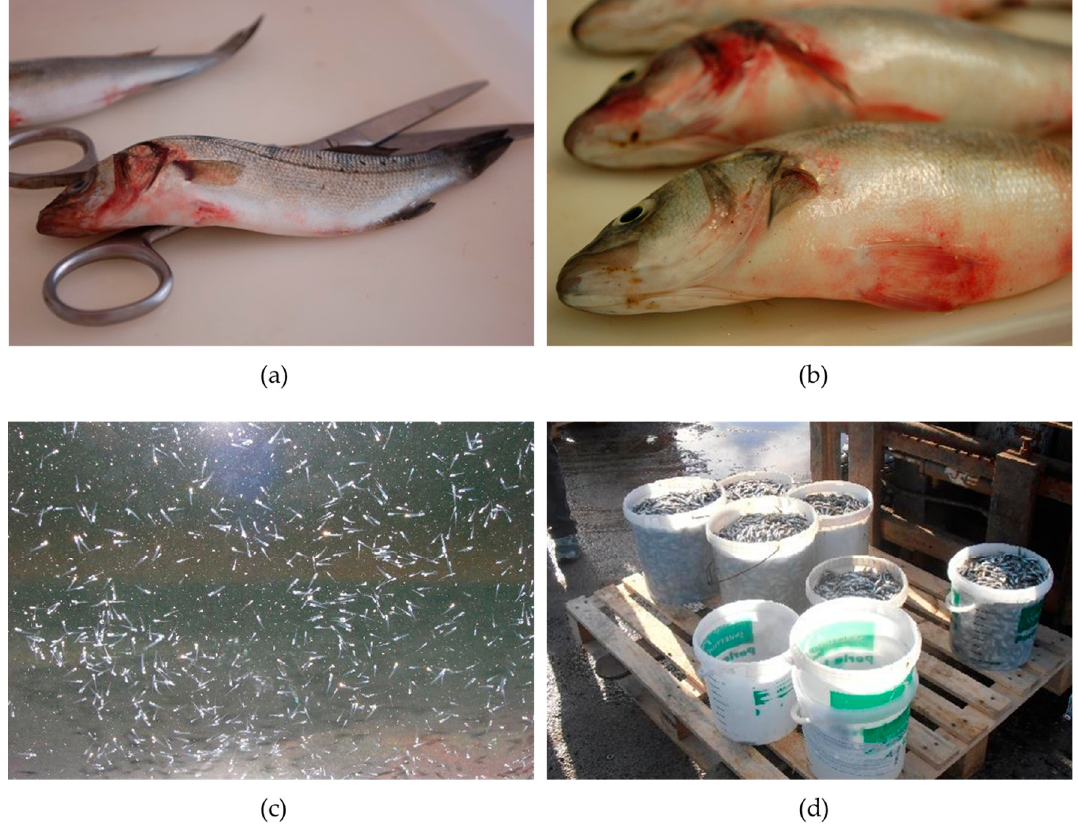
Figure 1. Massive mortalities caused by vibriosis in different developmental stages. ( a , b ) cultured European seabass, Dicentrarchus labrax , ( c ) cultured European seabass, Dicentrarchus labrax fry and ( d ) cultured gilthead sea bream, Sparus aurata larvae in the hatchery.